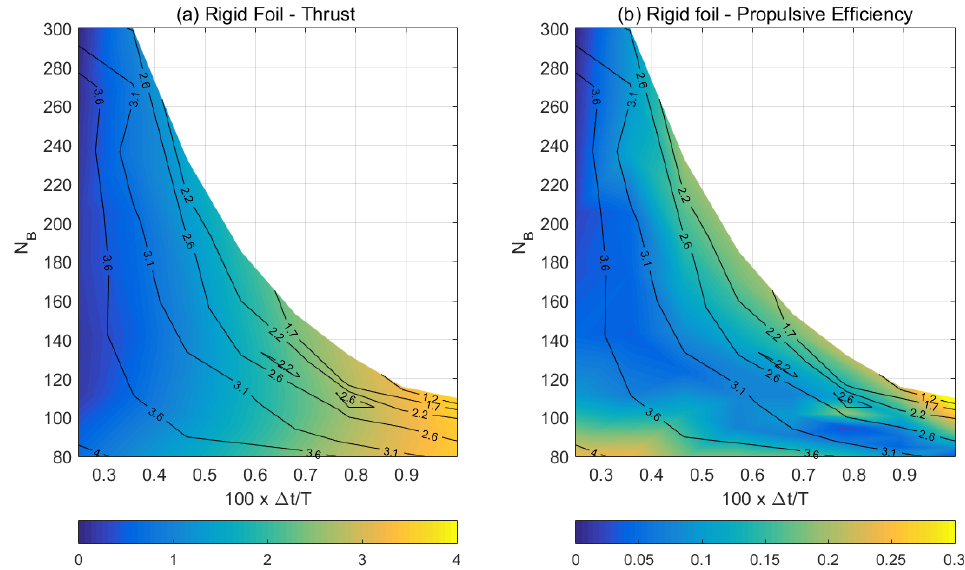
Figure 6. Relative error (%) of ( a ) the thrust e ffi ciency coe ffi cient C T (left) and ( b ) the propulsive e ffi ciency η F (right) with respect to the value of the finest discretization simulated with BEM–ABM. The error is denoted by the color-bar, and the contours display the iso- λ values. For the following kinematic parameters h o / c = 0.75, α ef f = 22 ◦ , Str = 0.2, x R = x LE , ψ = − 90 ◦ .